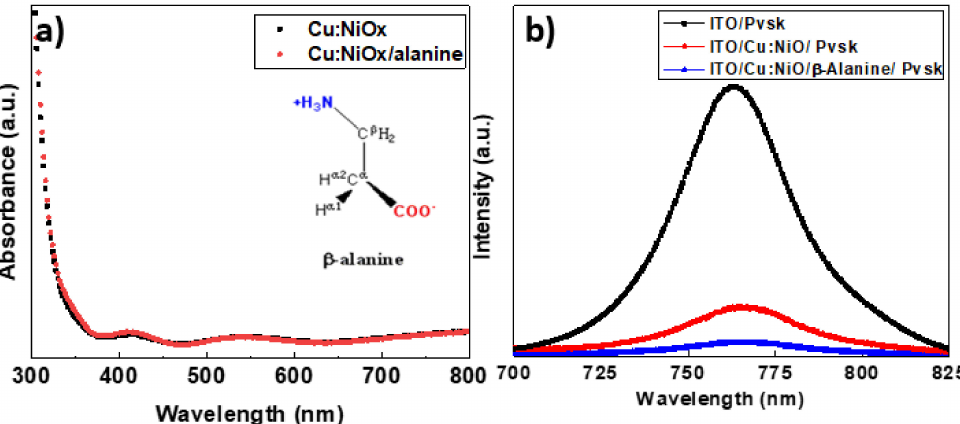
Figure 2. ( a ) Absorption spectra of ITO / Cu:NiOx, ITO / Cu:NiOx / β -alanine and β -alanine structure that used for the surface treatment method (the inset of Figure 2a provides the chemical structure of β -alanine used for the proposed surface treatment). ( b ) PL spectra of ITO / Pvsk, ITO / Cu:NiOx / Pvsk, ITO / Cu:NiOx / β -alanine /